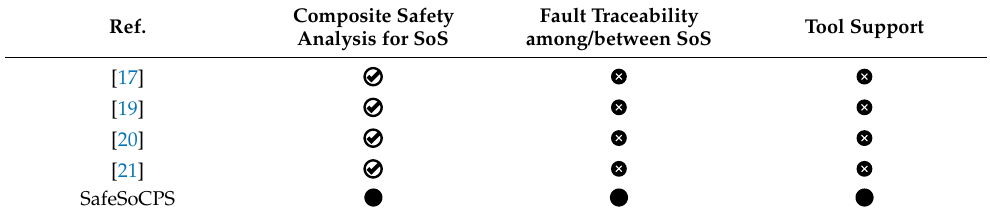
Table 1. Summary of related work . Ref.